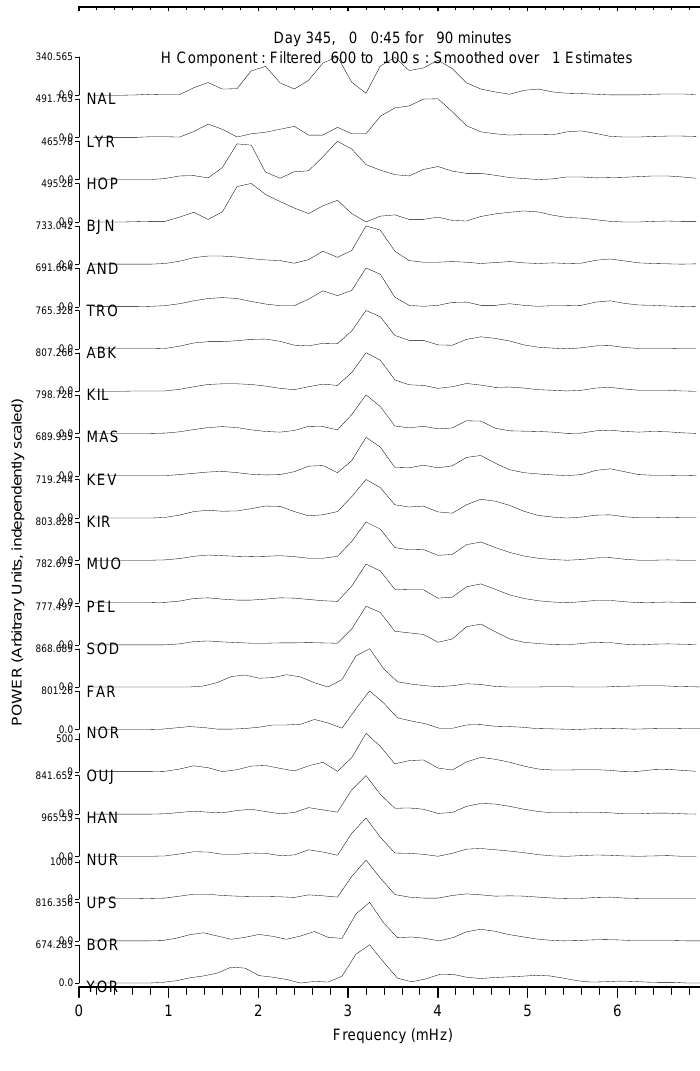
Fig. 14. Stacked H -component power spectra for the selected SAMNET and IMAGE magnetometer stations shown in Fig 14. Each power spectra is inde- pendently